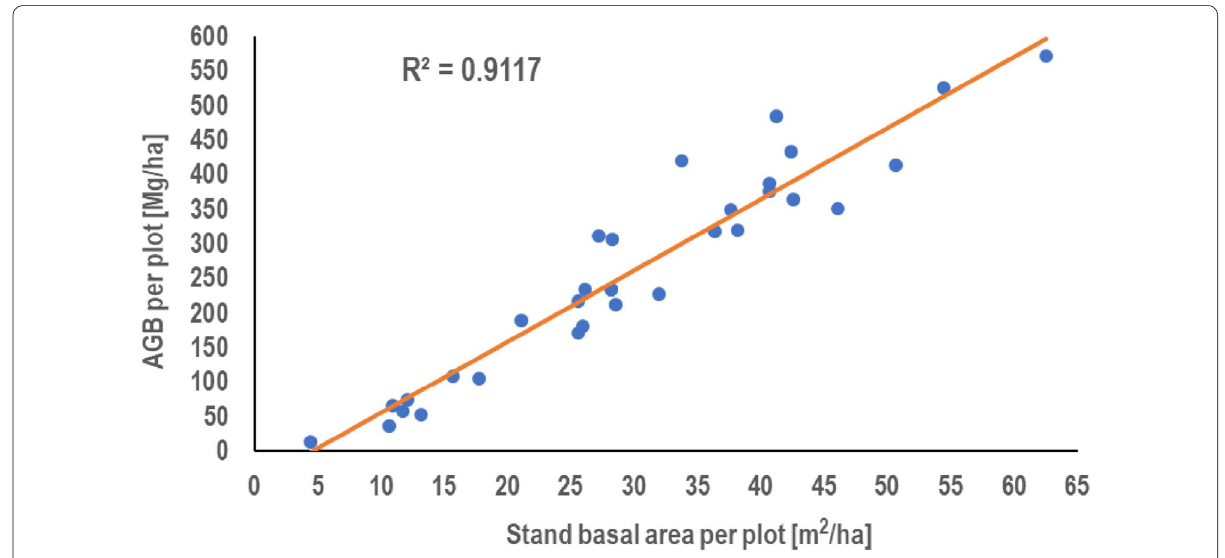
Fig. 7 Scatter plot showing the relationship between AGB versus stand basal area per